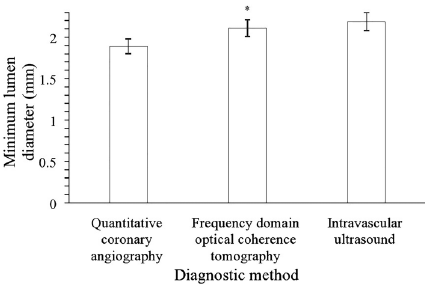
Figure 2. Minimum lumen diameter statistics. Data are reported as means ± SD. Data of 250 patients were included in the analysis. *P o 0.05 compared to the other diagnostic methods (ANOVA and Tukey post hoc test).